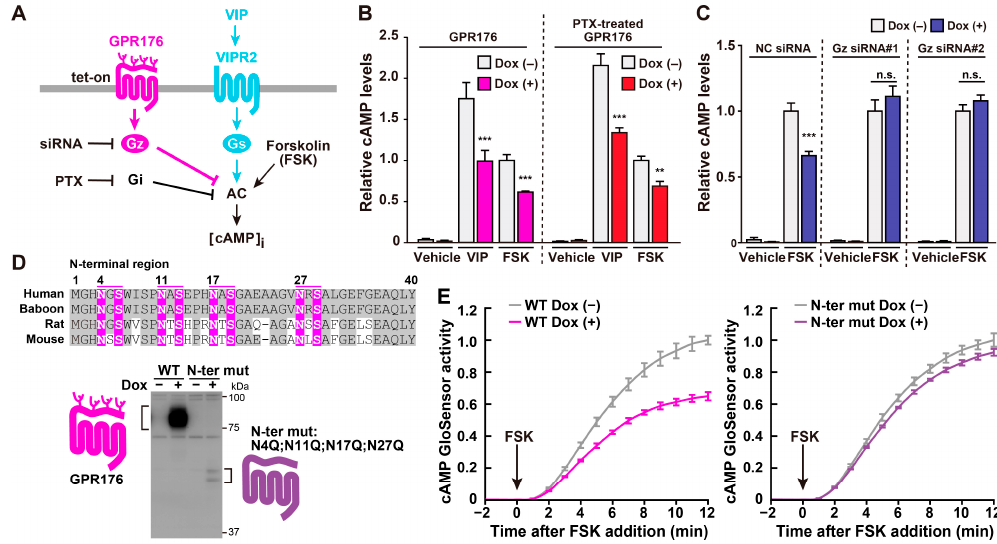
Figure 4. Biochemical features of GPR176: agonist-independent constitutive activity, G z coupling, and N -glycosylation. ( A ) Generation of GPR176 tet-on cells constitutively expressing VIPR2. ( B ) Antagonistic activity of GPR176 on VIP- and forskolin (FSK)-stimulated cAMP accumulation in GPR176 tet-on cells. Cells of the same batch were cultured in parallel with or without Dox for 24 h, then resuspended in assay buffer for 1 h and stimulated with VIP or FSK for 15 min. Where specified,